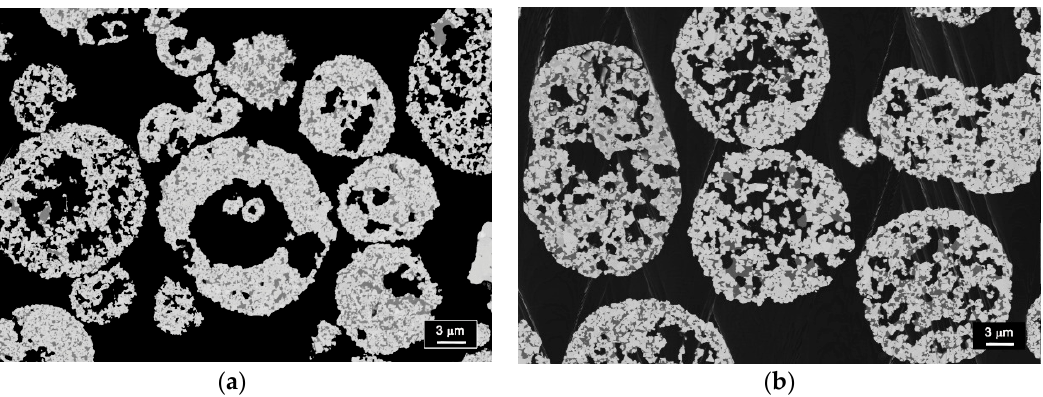
Figure 2. Cross section of WC powders showing their microstructures: ( a ) CGS and ( b ) HVAF